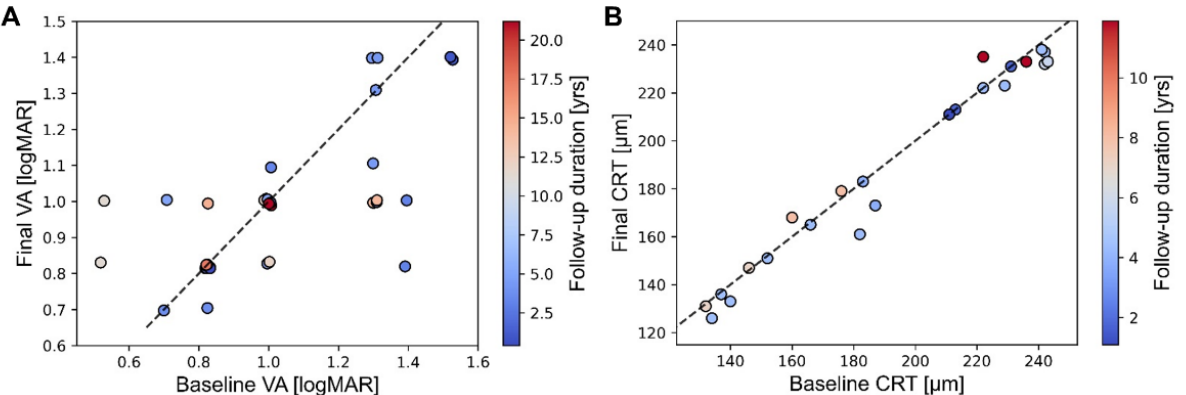
Figure 1. Changes in the best corrected visual acuity (BCVA) and central retinal thickness (CRT) in the patients with achromatopsia. The color of each mark denoted the follow-up duration between the baseline and the final visit when the BCVA or CRT was measured. ( A ). No significant changes in the BCVA were observed in either of the eyes. ( B ). A significant change in the mean CRT was observed in the left eyes, while it was not observed in the right eyes.